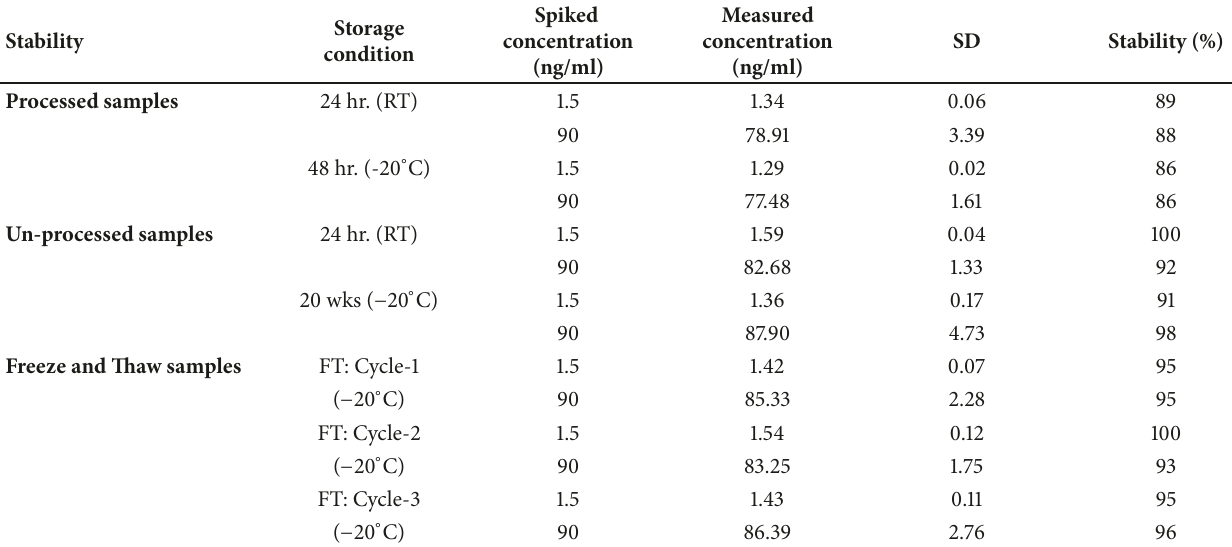
Table 3: Stability of cortisol in human saliva.